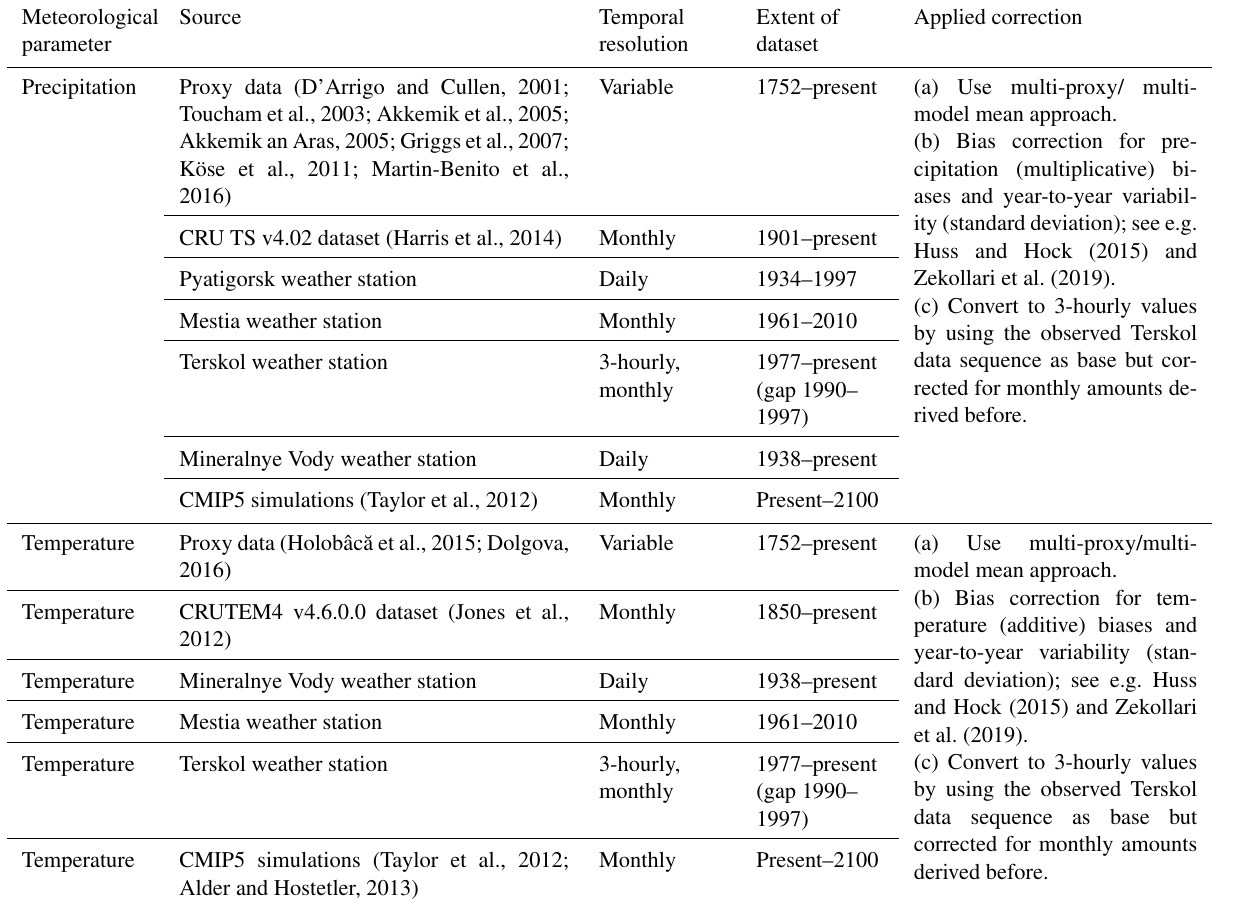
Table 2. Input data used for the Terskol climate reconstruction